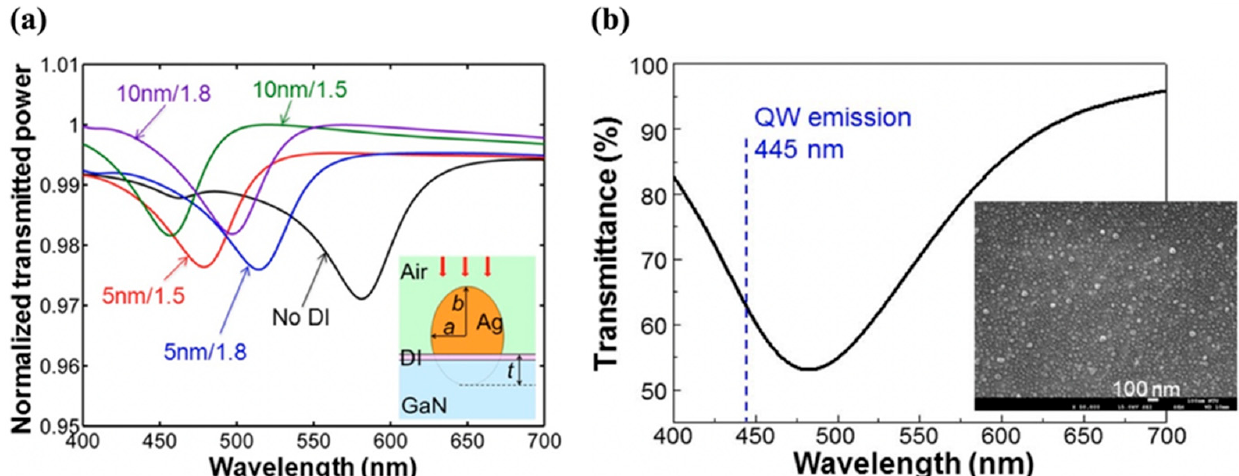
Figure 8. ( a ) Simulated normalized transmission spectra of an AgNP with various DI conditions, including the case of no DI and the cases of DI thicknesses at 5 and 10 nm and refractive indices at 1.5 and 1.8. The insert shows the geometry of simulation, including the definitions of parameters a, b, and t. Reproduced with permission from [52]. Copyright 2014 AIP Publishing. ( b ) Transmission spectrum of the AgNPs on a GaZnO/u-GaN template. The vertical dashed line indicates the QW emission wavelength at 445 nm. The inset shows the SEM image of the surface AgNPs fabricated on the GaZnO layer. Reprinted with permission from [16]. Copyright 2018 The Optical Society.